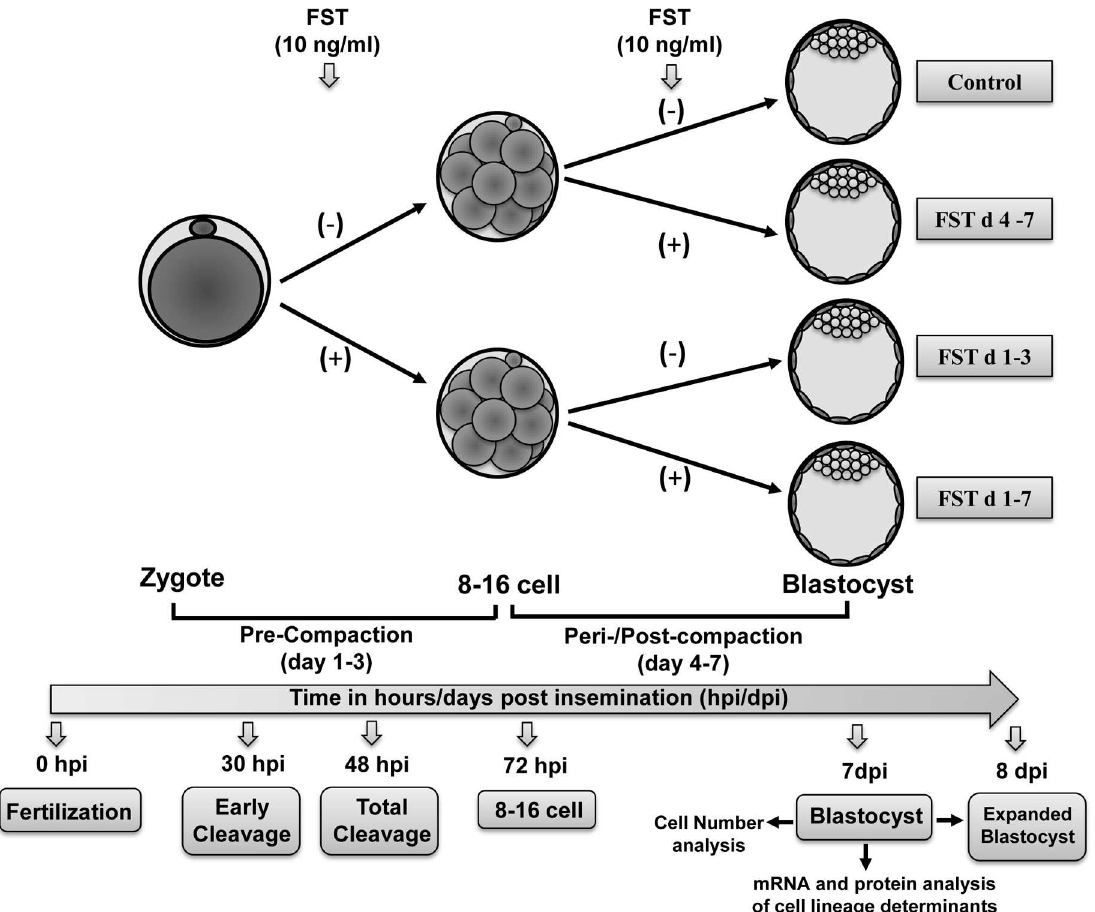
Fig 1. Experimental design of this study. After 20 hrs of fertilization,presumptive zygotes were cultured from day (d) 1–3 (pre-compaction period) in the presenceand absenceof 10 ng/ml follistatin(FST). At day 3, 8–16cell embryos from control and follistatin treatment group were further culturedfrom day 4–7 (peri-/post-compactionperiod)in the absenceand presenceof follistatin (10 ng/ml). Early cleavage,total cleavage,8–16 cell, d7 blastocyst and expanded blastocyst stages of pre-implantation embryo development were recordedat in all the treatment group includinguntreatedcontrol, FST d 4–7, FST d 1–3, and FST d1-7. Blastocysts from all the treatment groups were collectedat day 7 and analyzedfor cell number(total, TE, ICM) and mRNA and protein abundancefor select markers/determinants of blastocyst cell